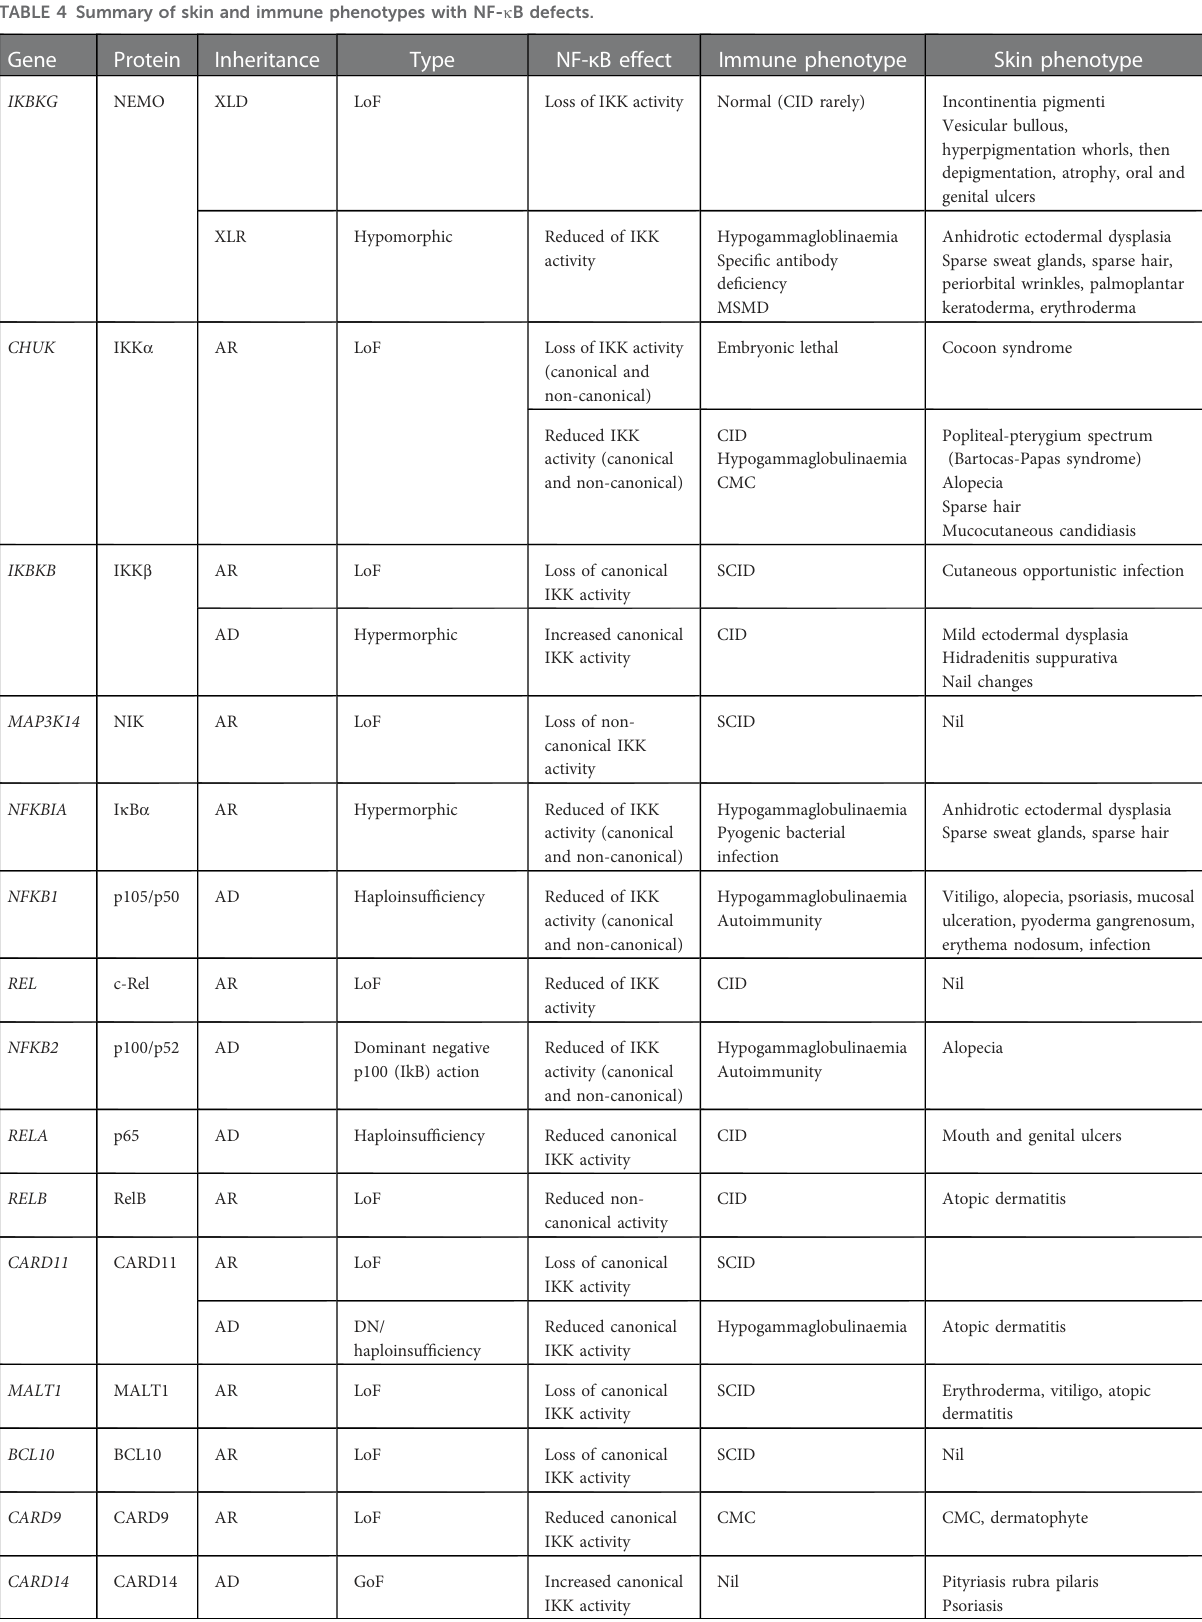
TABLE 4 Summary of skin and immune phenotypes with NF- κ B